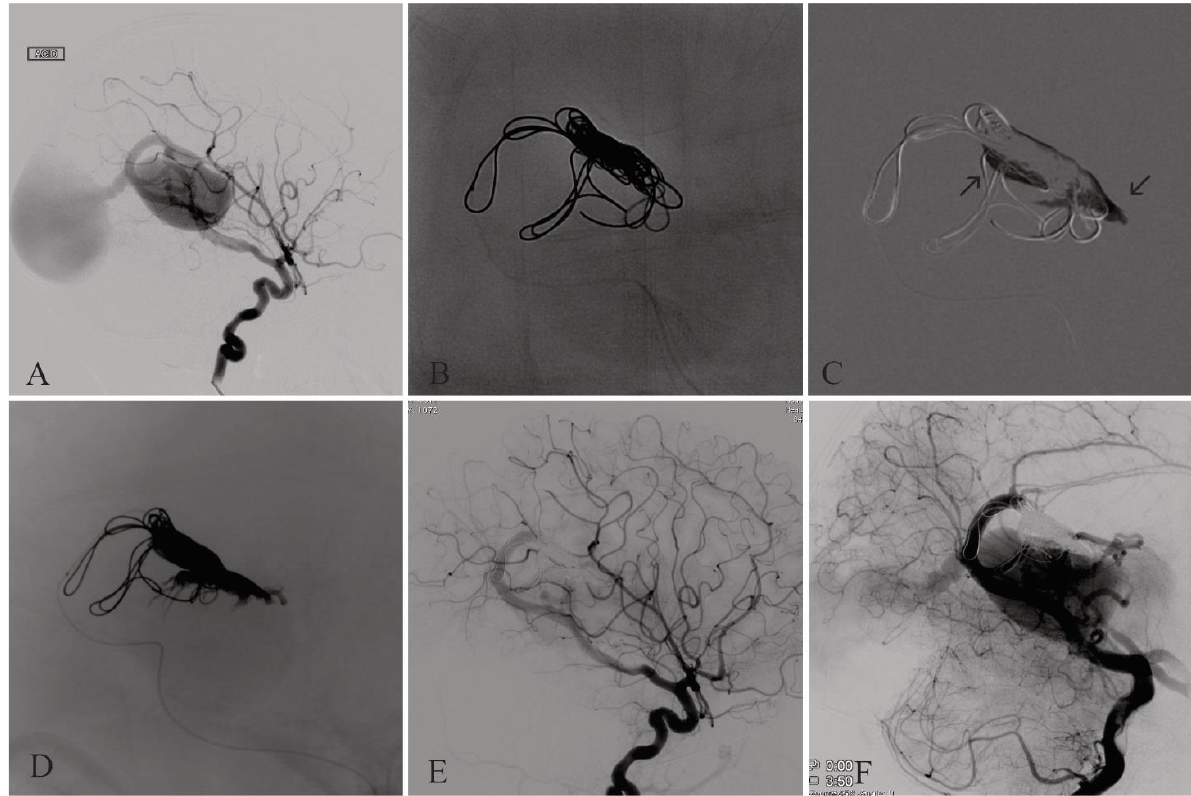
Figure 1 - (A) Digital subtracted angiography (DSA) lateral view of the right internal carotid injection showing a mural type Vein of Galen malformation nourished by the anterior choroidal artery, (B) cast of coils in the anterior choroidal branch to the VGAM, (C) Roadmap lateral view showing an injection of EVOH (Onyx-Medtronic) through the cast of coils, (D) X- ray of the head lateral view showing the final cast of coils and Onyx forming a “mushroom like” shape, (E) DSA lateral view of the right internal carotid artery showing occlusion of the anterior choroidal branch, (F) DSA lateral view of the left vertebral artery showing a second mural shunt of the posterior choroidal artery to the